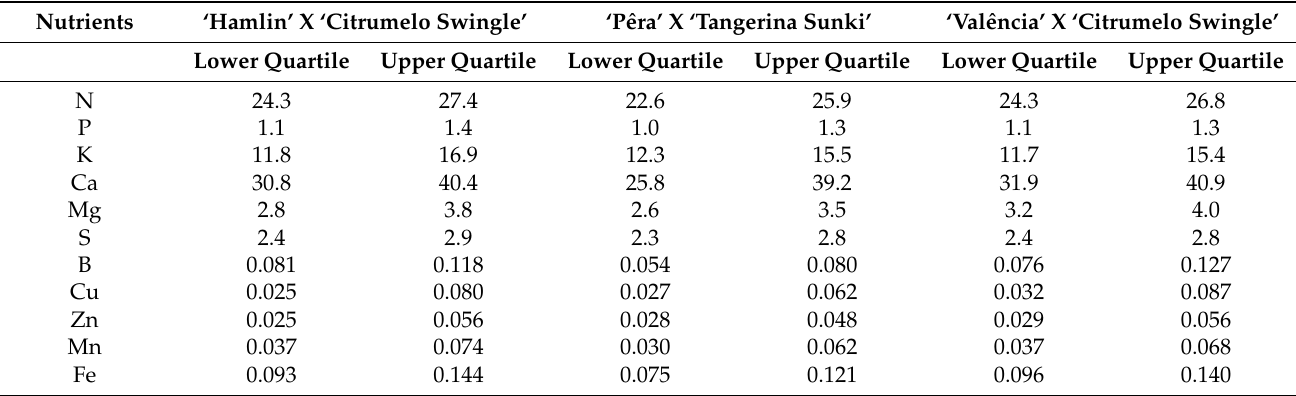
Table 7. Lower and upper quartiles of true negative specimens of ‘Hamlin’ X ‘Citrumelo